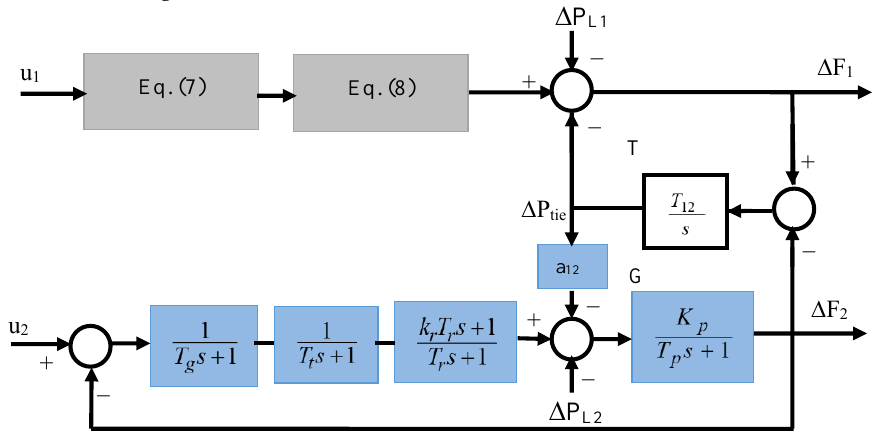
Figure 5. The PV